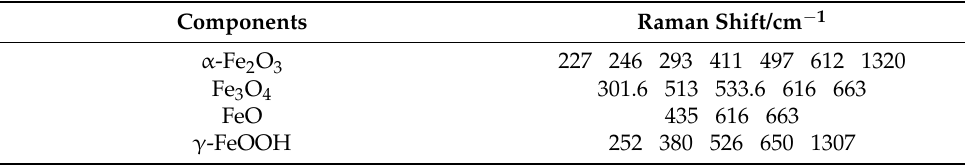
Figure 5. Raman spectra of samples before/during/after the reduction process. Table 2. Raman shifts of different iron oxides